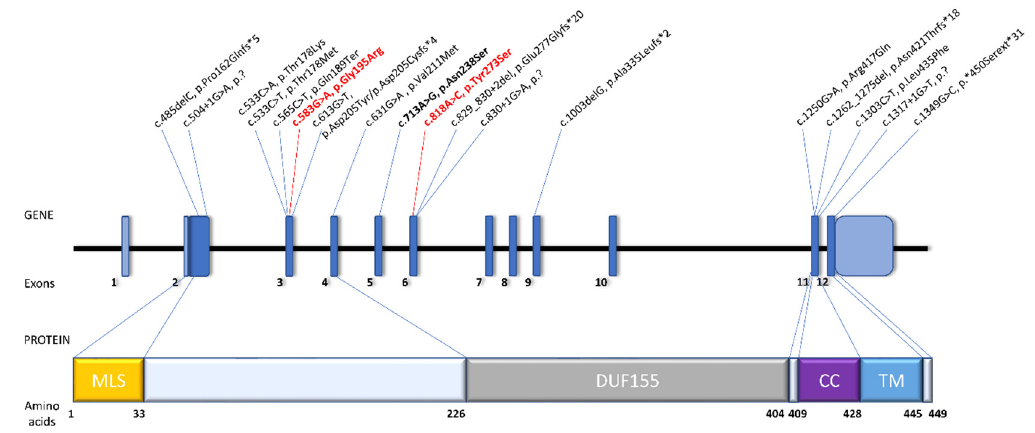
Figure 3. Schematic representation of RMND1 gene and protein organization. Gene and protein structure is depicted based on the canonical transcript NM_017909.4 and reference protein sequence NP_060379.2. Previously reported RMND1 pathogenic variants involved in development of combined oxidative phosphorylation deficiency (COXPD11) are written in black. Variants identified in this study are shown in red. Bolded are variants involved in the development of Perrault syndrome (PRLTS) with renal involvement. Abbreviations: MLS, mitochondrial localization sequence; DUF155, domain of unknown function; CC, coiled-coil; TM, transmembrane.